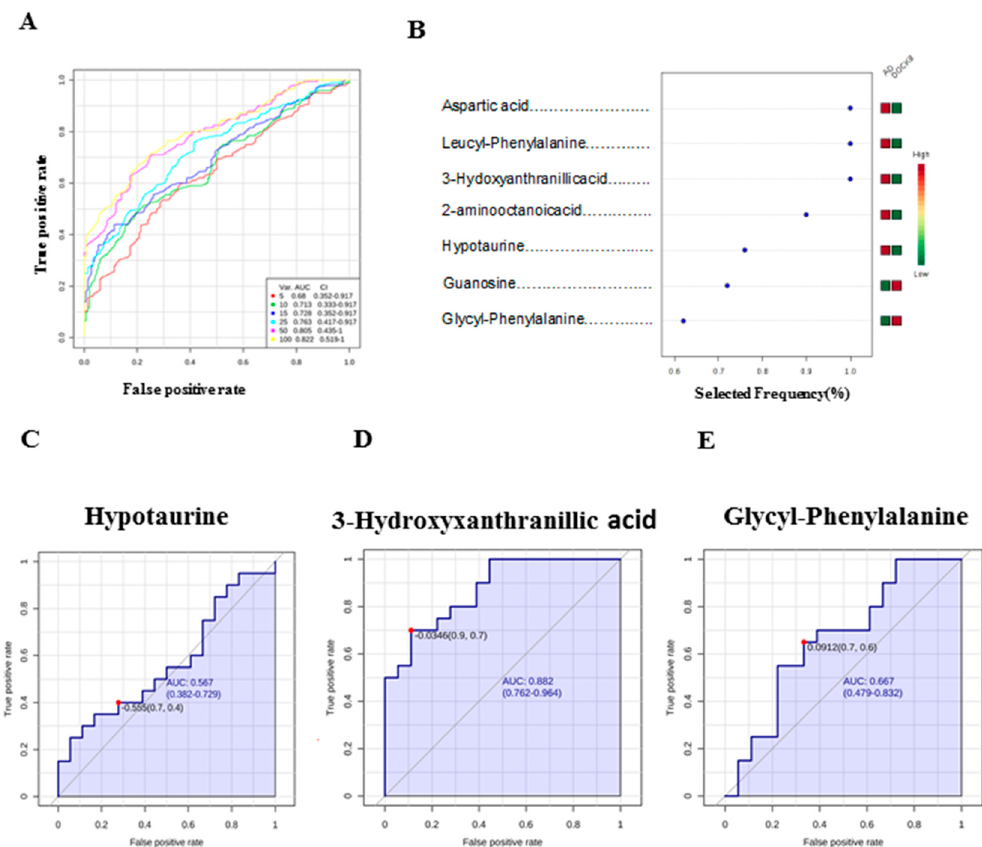
Figure 4. Receiver operating characteristics (ROC) curve and loading plots for positively identified serum metabolites in the comparison between DOCK8-deficient and AD patients. ( A ) ROC was generated by the PLS-DA model showing an area under the curve (AUC) = 0.822. ( B ) Frequency plot with seven positively identified metabolites. ( C ) Hypotaurine is not significantly expressed in DOCK8-deficient patients, AUC = 0.567 and p -value of 0.41537. ( D ) 3-Hydroxyxanthranillic acid is up-regulated in DOCK8-deficient patients, AUC = 0.882 and p -value of 4.4491 × 10 − 5 . ( E ) Glycyl- phenylalanine is down-regulated in DOCK8-deficient patients compared with AD patients, AUC = 0.667 and p -value of 0.04766. Data were normalized; transformed; and scaled by median, log, and Pareto scaling to make sure all the data are under the Gaussian distribution. For paired analysis, a combination of t-test and fold change analyses are represented, where the x -axis (FDR-corrected p -value) and the y -axis are true positive. Abbreviations: DOCK8, dedicator of cytokines8; AD, atopic dermatitis; Ctrl, healthy